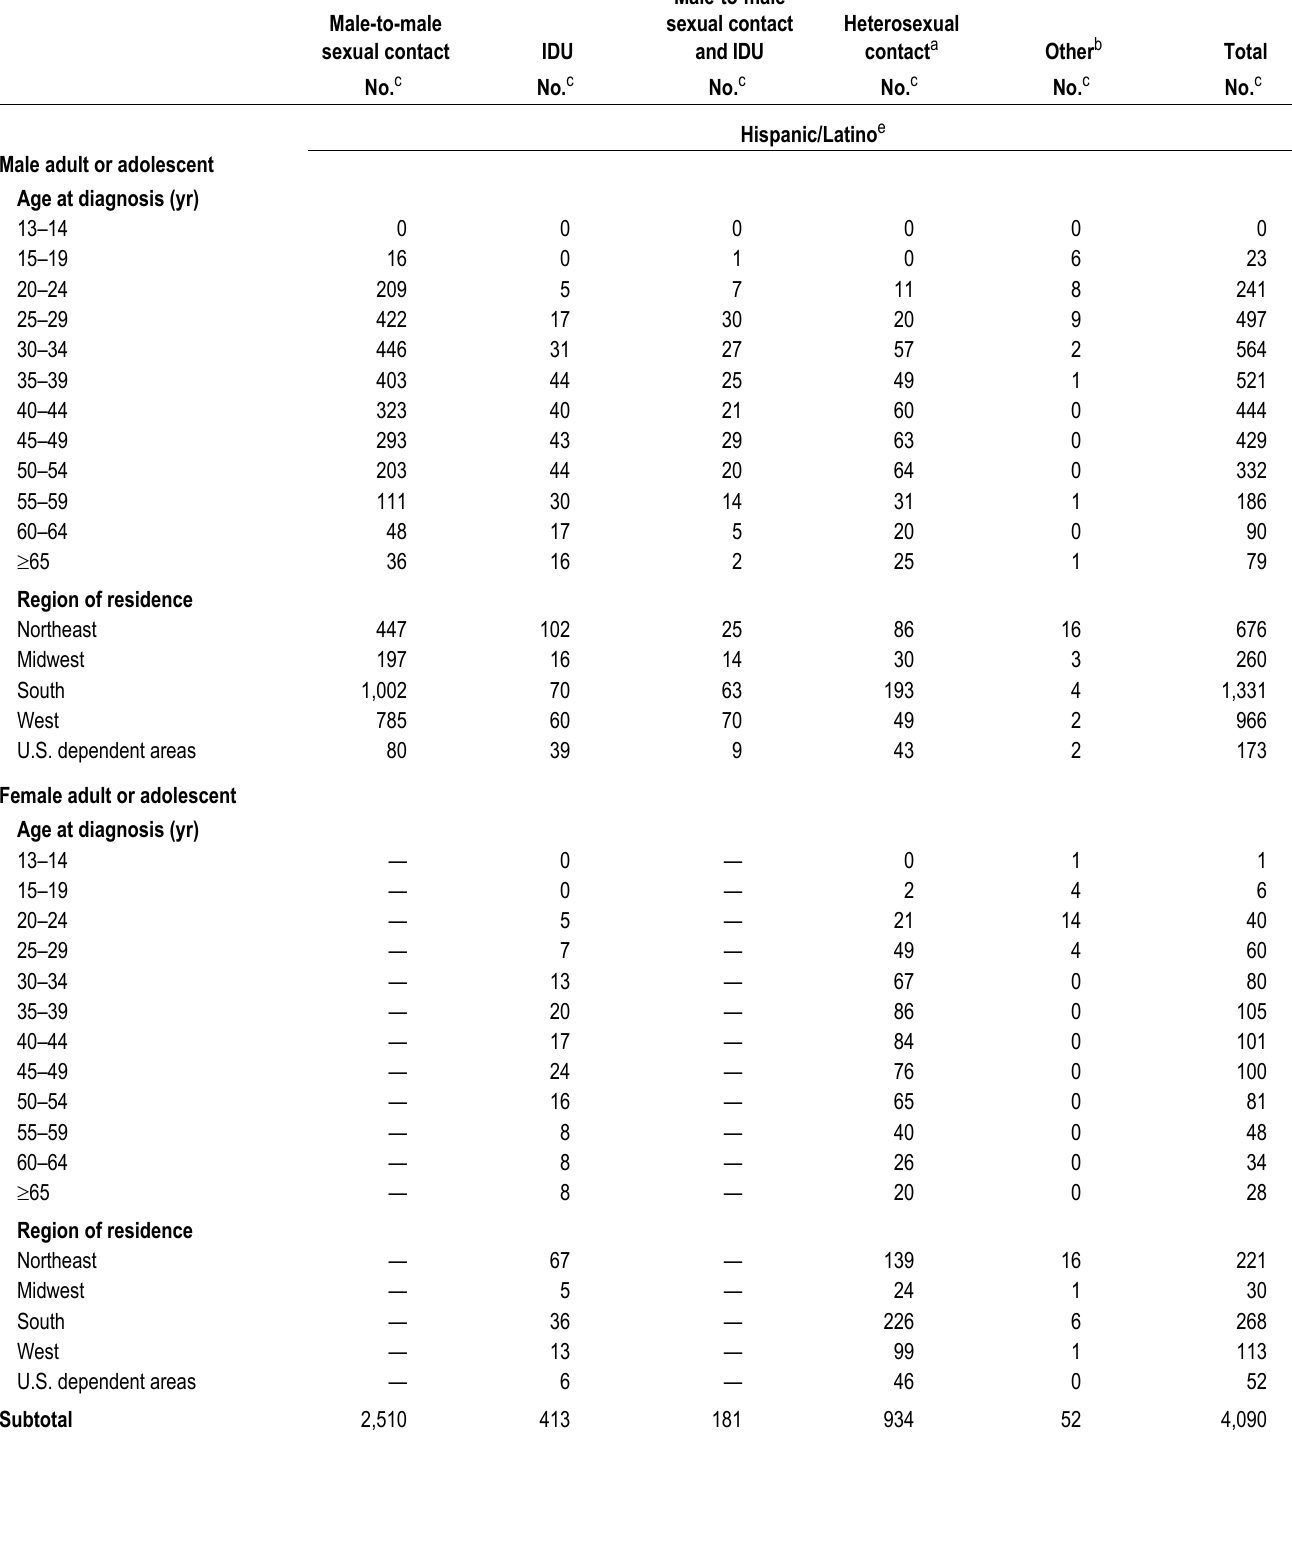
Table 6b. Stage 3 (AIDS), by transmission category, race/ethnicity, and selected characteristics, 2015—United States and 6 dependent areas